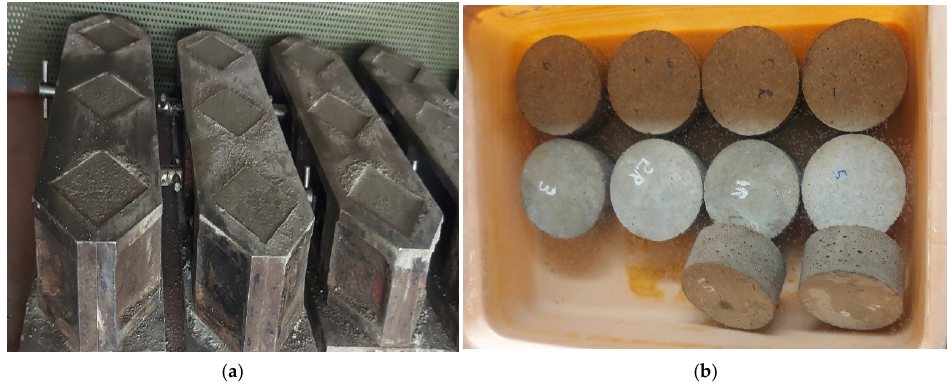
Figure 2. ( a ) Mortar cube molds. ( b ) Mortar cylindrical discs. Table 1. Details of experimentation .